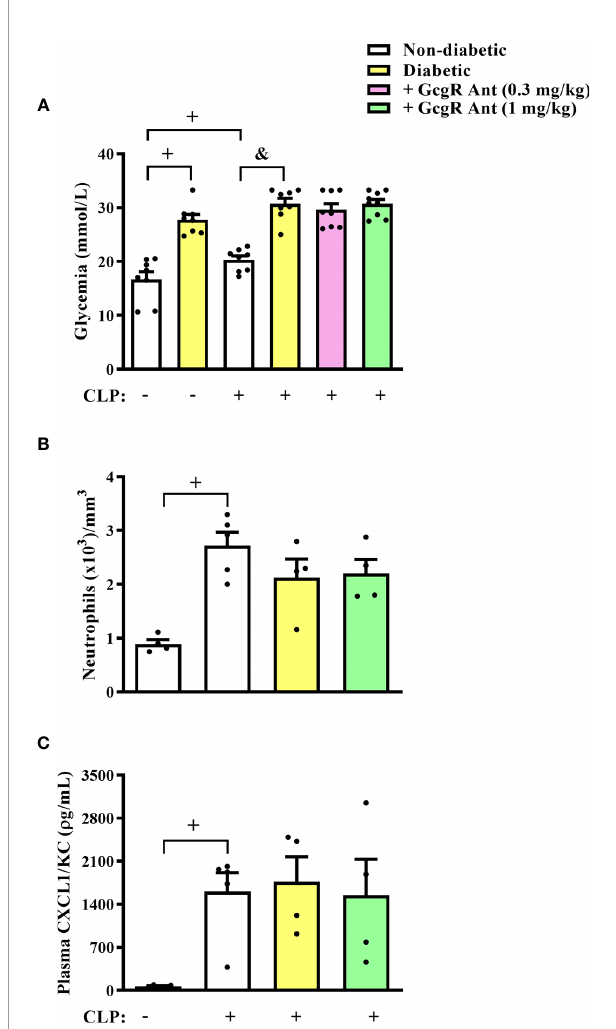
FIGURE 2 | GcgR antagonist did not alter glycemia and systemic in fl ammation in diabetic mice after CLP induction. CLP was performed 21 days after diabetes induction, and the treatment with GcgR antagonist was carried out 24h and 1h before CLP. (A) Glycemia. (B) Analysis of blood neutrophil numbers. (C) Plasma levels of CXCL1/KC. For (A, B) analysis were realized 3h after CLP. For (C) analysis was realized 20h after CLP. Each value represents the mean ± S.E.M. For (B) , each sample value was obtained in blinded and randomized counting. The statistical analysis was performed by one-way ANOVA, followed by Newman – Keuls – Student ’ s t-test. Results are representative of one individual assay. + P < 0.05 compared to sham non- diabetic mice. & P < 0.05 compared to CLP non-diabetic mice. CLP, Cecum ligation and puncture; GcgR Ant, GcgR Antagonist.